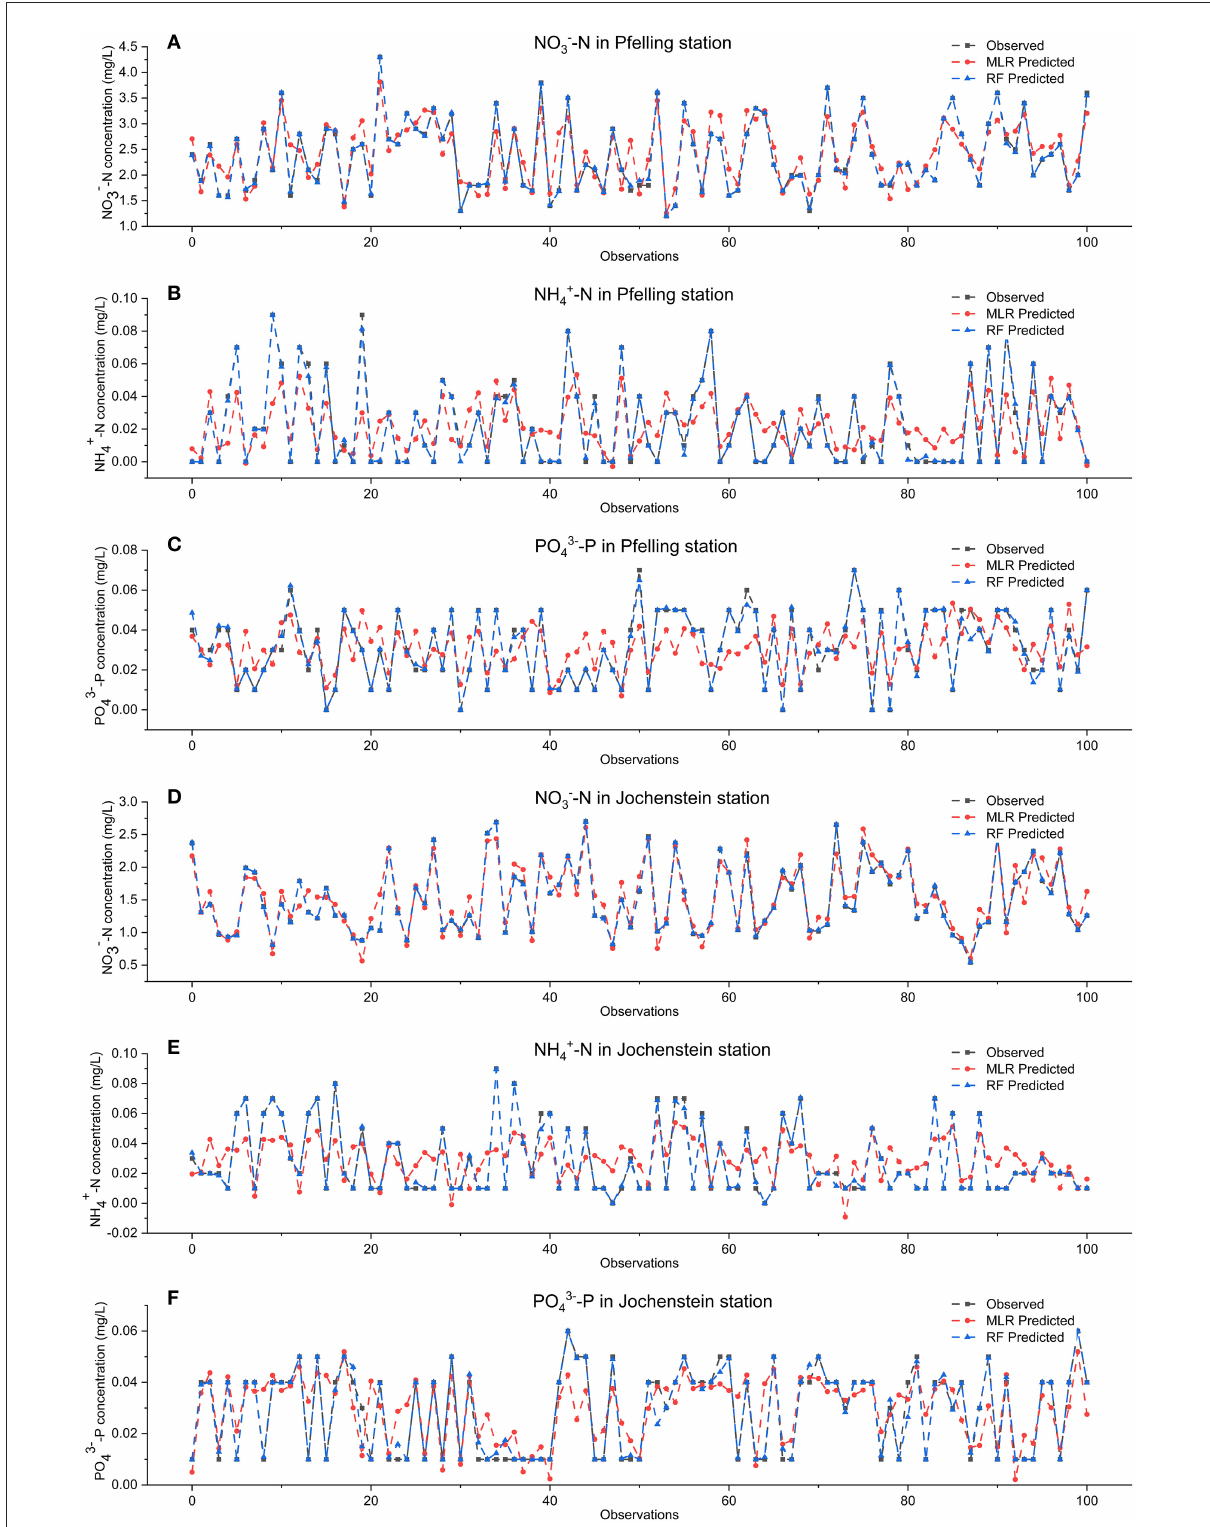
FIGURE5 Observed and predicted values for the first 100 observations of the testing dataset in Pfelling and Jochenstein station. (A) NO − 3 -N Pfelling. (B) NH + 4 -N Pfelling. (C) PO 3 − 4 -P Pfelling. (D) NO − 3 -N Jochenstein. (E) NH + 4 -N Jochenstein. (F) PO 3 − 4 -P